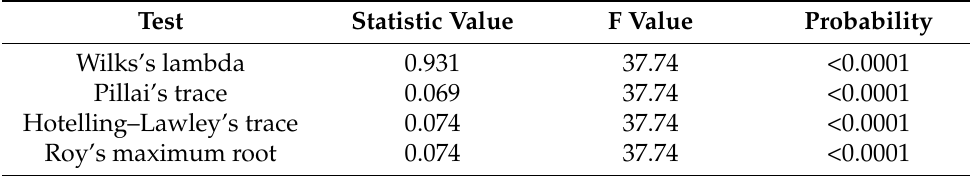
Table 4. Results of MANOVA on rank variables.